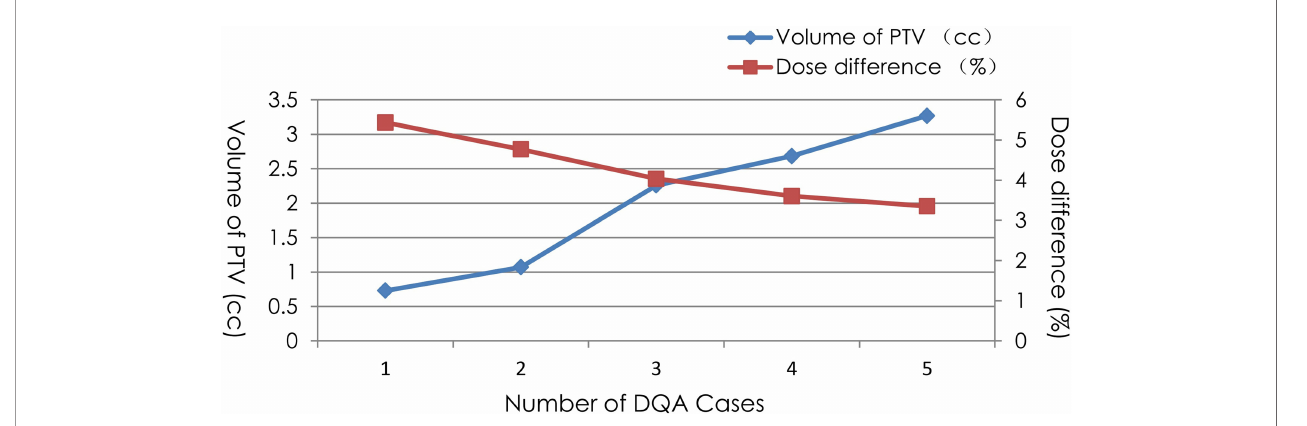
FIGURE 2 | Characteristics of PTV volume and point dose difference for 5 cases dissatisfying with the acceptance